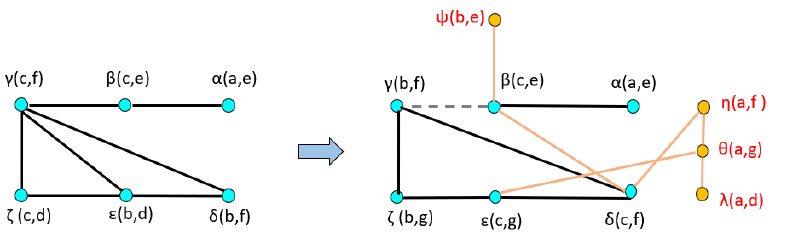
Figure 19. Dual graph representation and comparison of joint vocabulary between initial model M 0 and model M 1